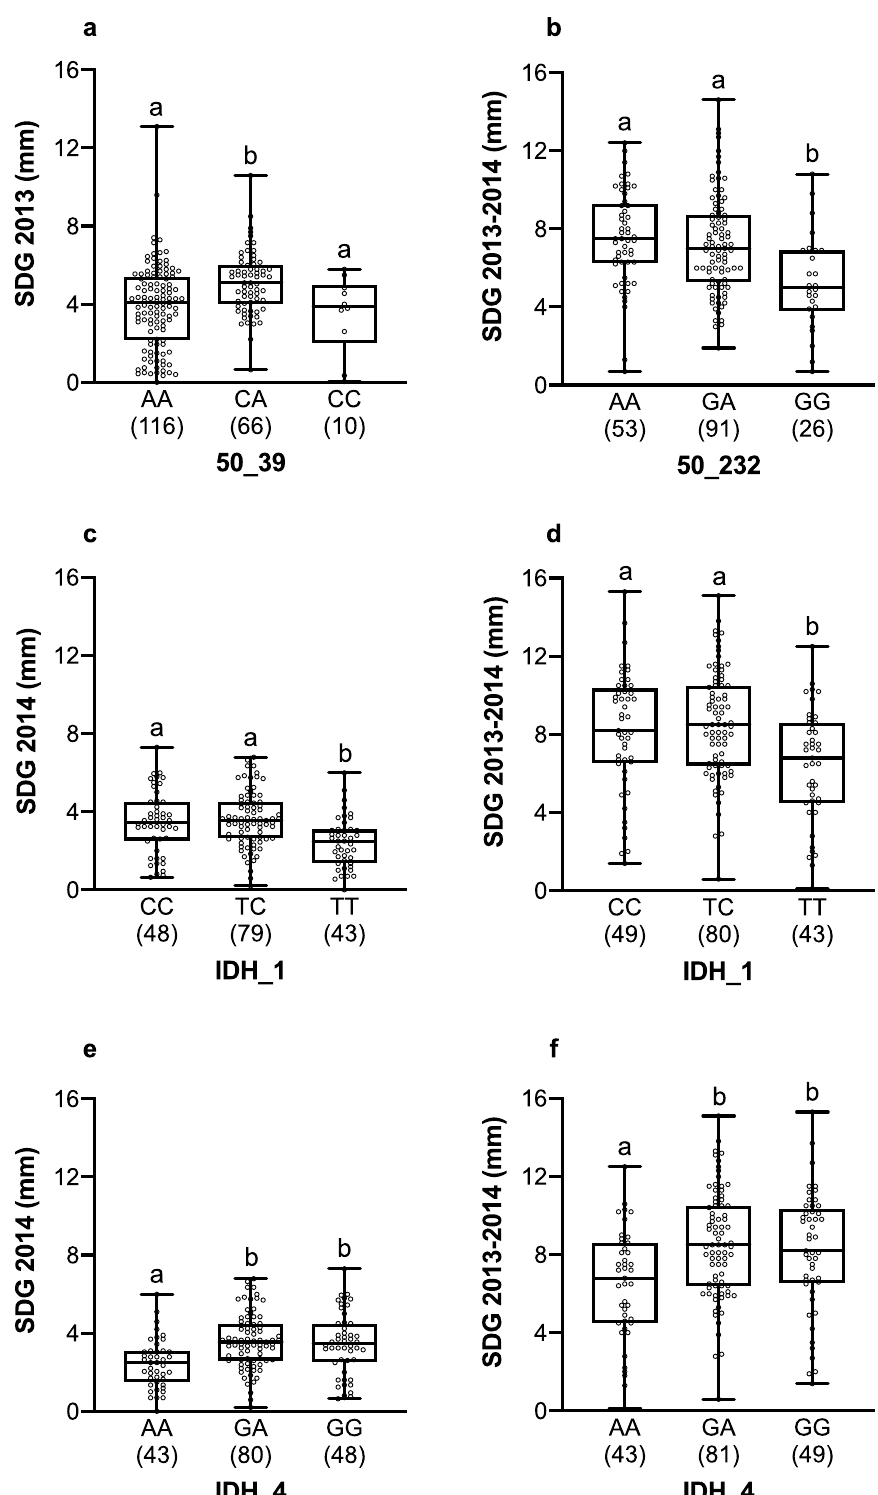
Figure 4. Stem diameter growth (SDG) measured in homozygote and heterozygote genotypes of four SNPs ( 50_39 , 50_232 , IDH_1 , and IDH_4 ) that were significantly associated with SDG under drought/acidic ( a and b ) and drought/calcareous ( c , d , e , and f ) soil conditions. Different letters (a and b) above whiskers indicate significant differences ( P < 0.05). Box plots present median, upper and lower quartiles; whiskers show minimum and maximum values. Sample size is presented in